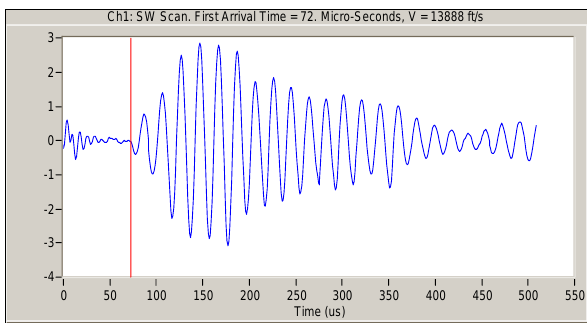
Figure 6. Sample data from UPV showing pulse travel distance of 12", compressional wave arrival time of 0.000072 seconds for a resulting velocity of 13,880ft/sec, which typically indicates good quality concrete